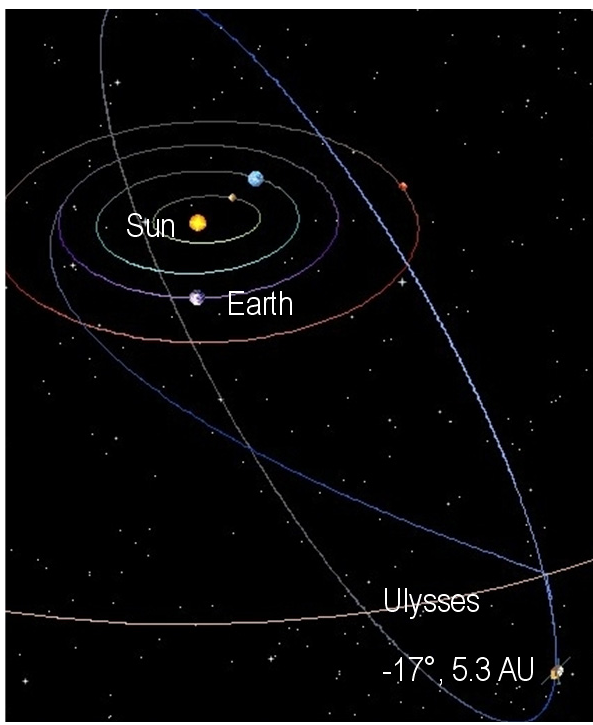
Fig. 13. Relative position of Ulysses and the Earth (ACE) for the events in January